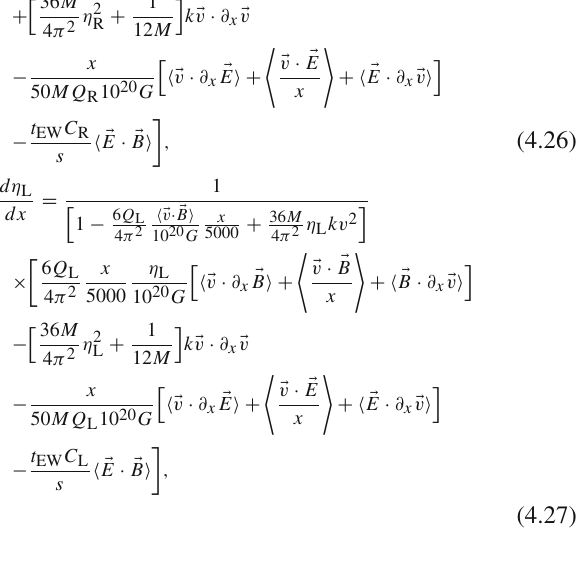
Fig. 6 Time plots of the differences between the results with and with- out the inclusion of the temporal components of the CVE, CME and diffusion currents given by the last three terms of Eq. (4.22): a the right- handed electron asymmetry (cid:8)η e